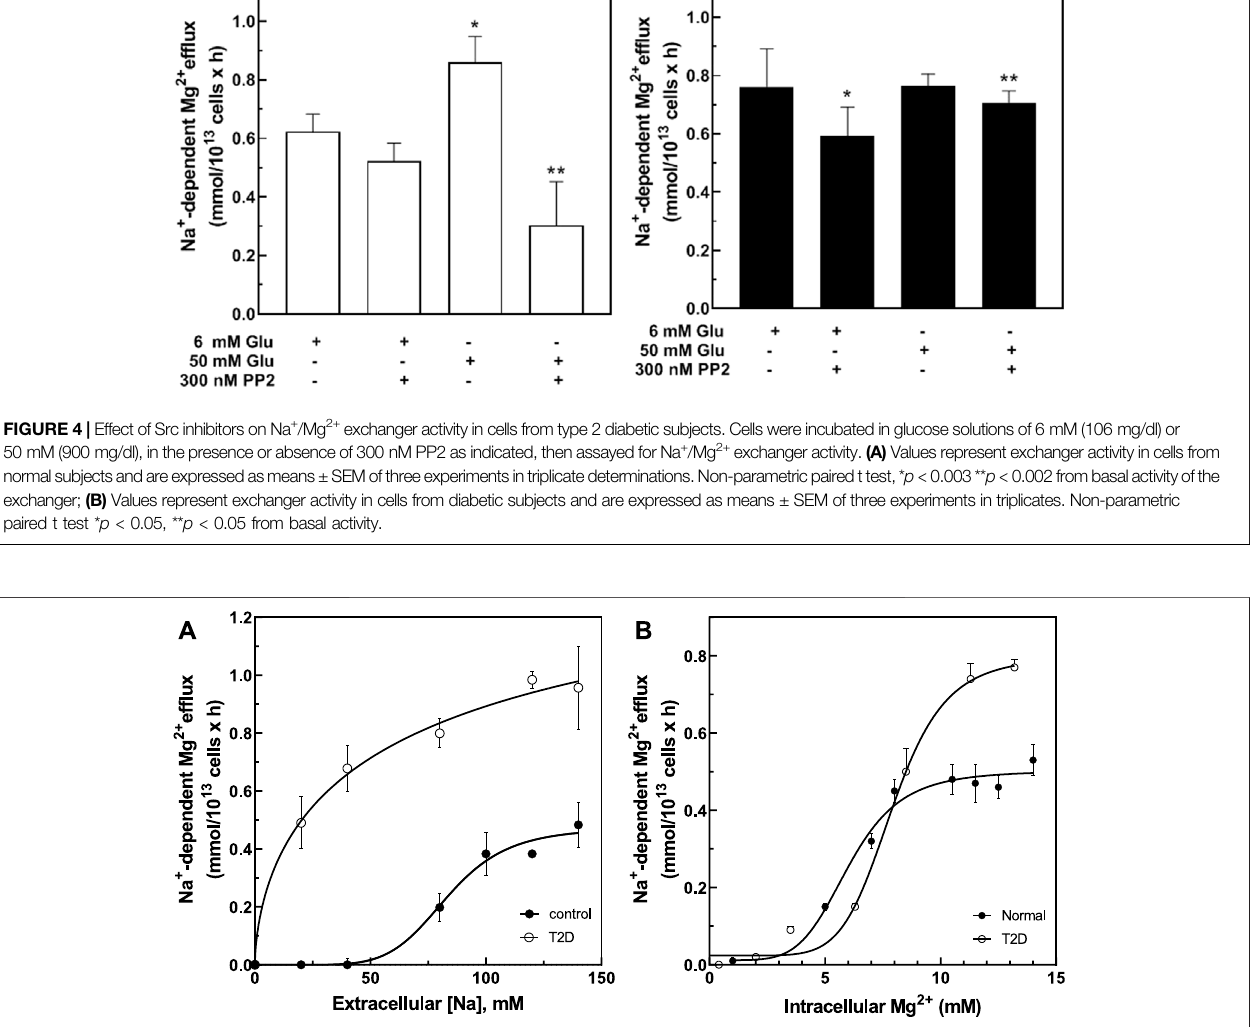
FIGURE 5 | Activation of Na + /Mg 2+ exchanger by extracellular Na + and intracellular Mg 2+ in cells from normal and type 2 diabetic subjects. (A) Activation of Na + /Mg 2+ exchangerbyextracellularNa + innormal(closedcircles,V max =0.472±0.01FU,hill=6.4±0.13,K 1/2 =83.5 mM, n =3)anddiabeticsubjects(opencircles,V max =1.16±0.05FU, K m =28.9±mM, n =3). (B) ActivationofNa + /Mg 2+ exchangerbyintracellularMg 2+ innormal(closedcircles,V max =0.50±0.02 mmol/10 13 cell×h,hill=5.1±0.1,K 1/2 =5.97± 0.2 mM, n = 3) and diabetic subjects (open circles, V max = 0.81 ± 0.032 FU, hill = 6.3 ± 0.2, K 1/2 = 7.87 ± 0.39 mM, n = 3). Values represent the activity of the Na + /Mg 2+ exchanger and are expressed as means ± SEM of n = 3 in triplicates